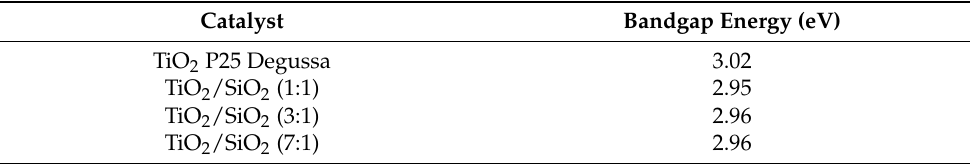
Figure 5. Tauc plot obtained through the application of Equation (3) for the photocatalyst of TiO 2 P25 Degussa and composite of TiO 2 /SiO 2 . Table 7. The bandgap values of the photocatalyst.